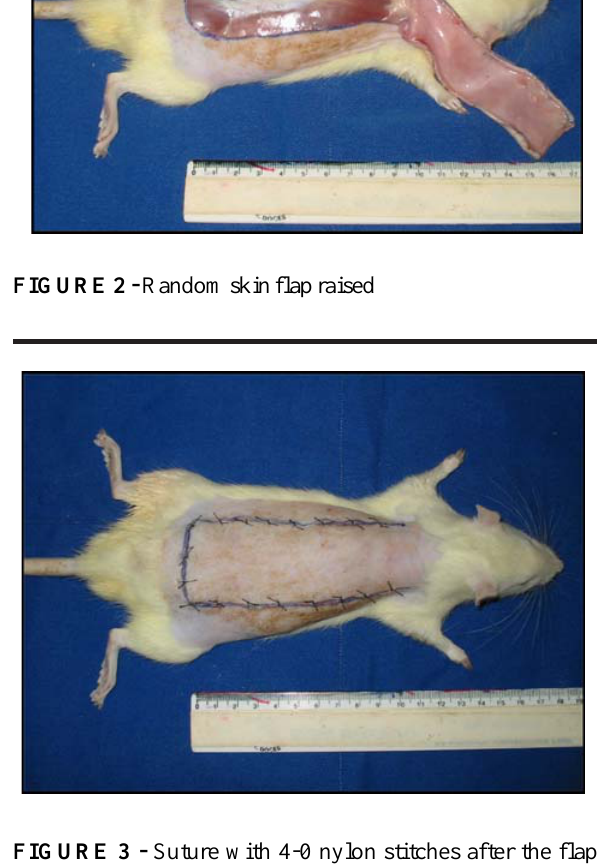
FIGURE 3 - Suture with 4-0 nylon stitches after the flap being raised and a plastic barrier